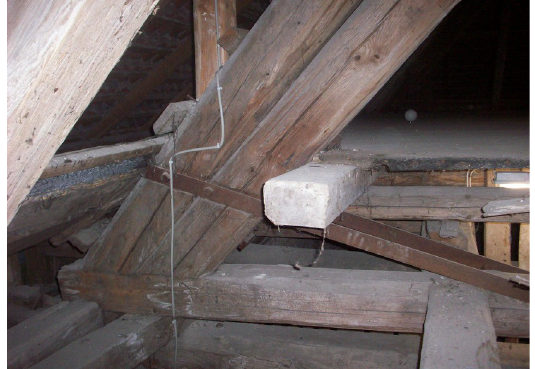
Figure 9. Photo of detail of the foot point of the Laves’ balken.